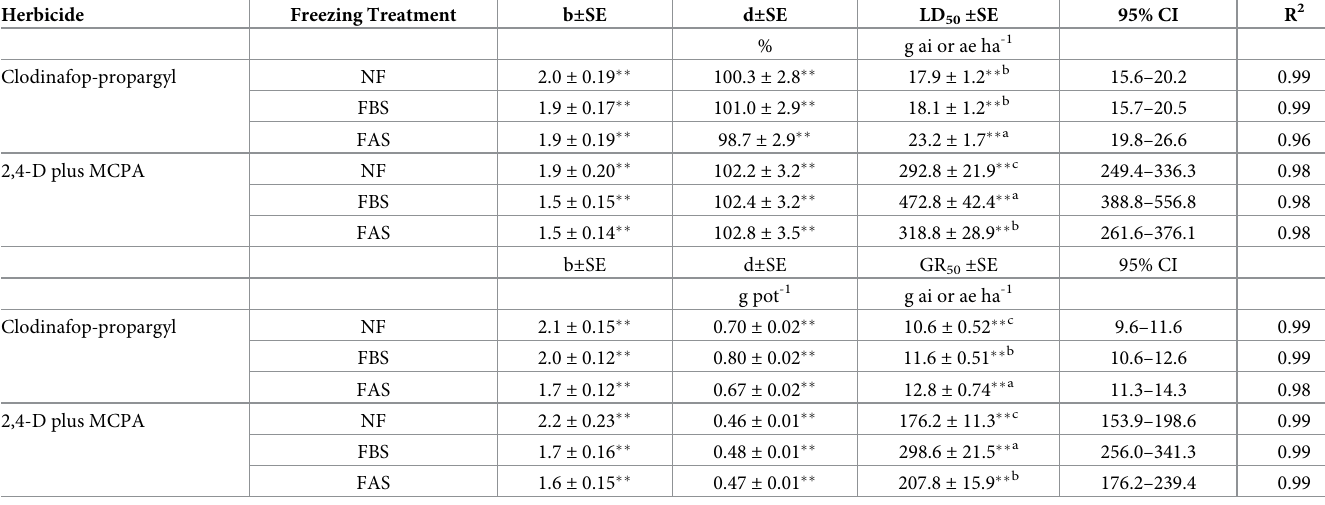
Table 1. The dose of clodinafop-propargyl and 2,4-D plus MCPA required for 50% mortality (LD 50 ) and the dose that caused 50% inhibition of growth noted by biomass (GR 50 ) of winter wild oat and turnipweed under different freezing treatments.